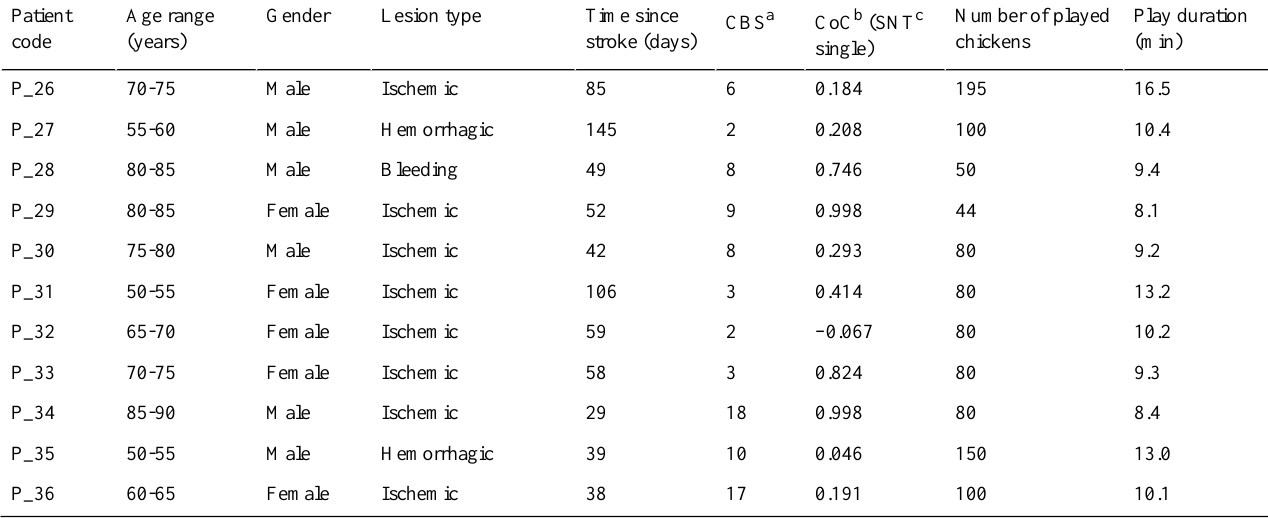
Table 2. Individual demographical and neuropsychological data from step 2 for patients with hemispatial